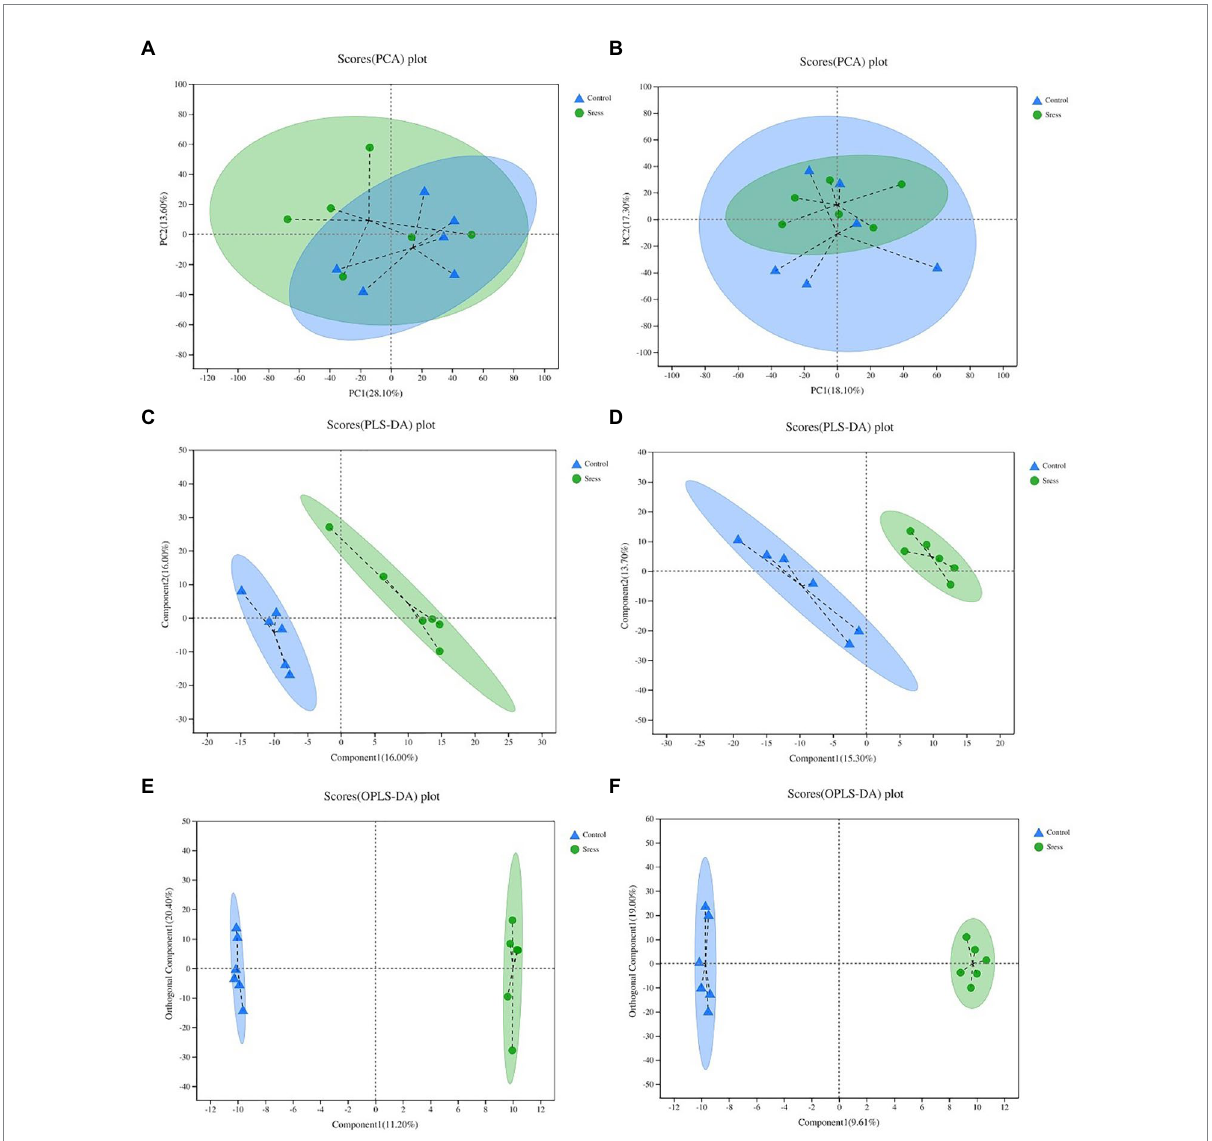
FIGURE 3 PCA, PLS-DA, OPL-DA analysis under the positive ion mode (A,C,E) and negative ion mode (B,D,F) . In the figure, Control represents the appropriate temperature group, and Stress represents the HT group, n